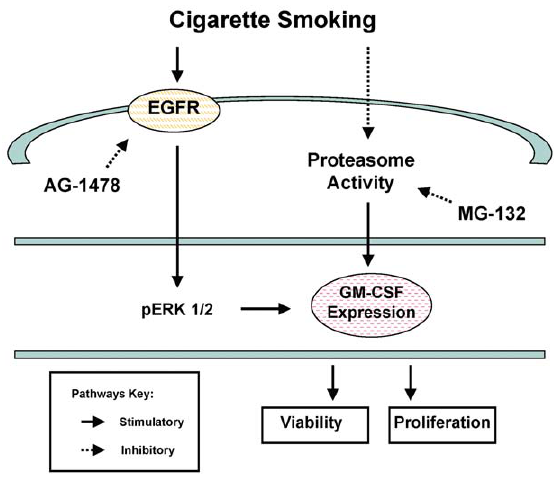
Figure 7. Cigarette smoke activates different signaling path- ways regulating trophoblast cell viability and proliferation via GM-CSF expression.